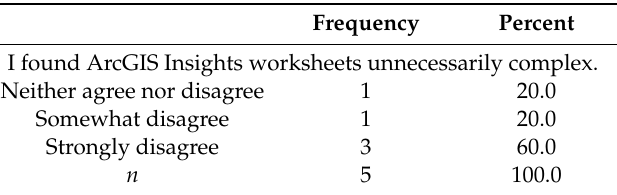
Table 4. Percentages and Frequencies, Q47.